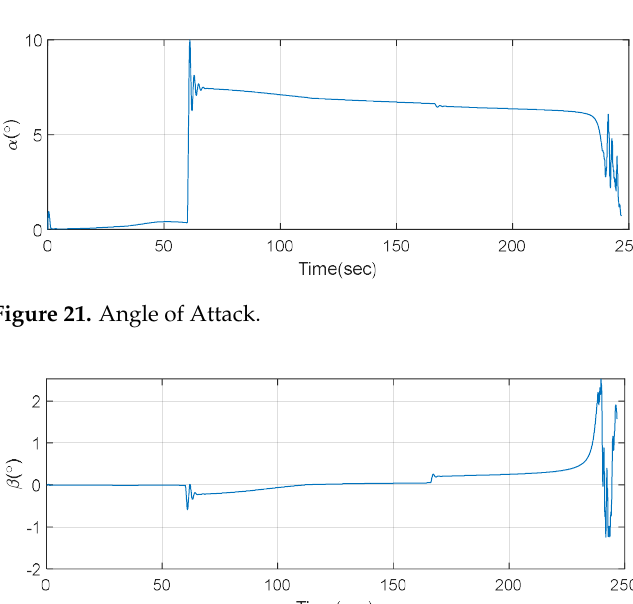
Figure 22. Angle of Side Slip.